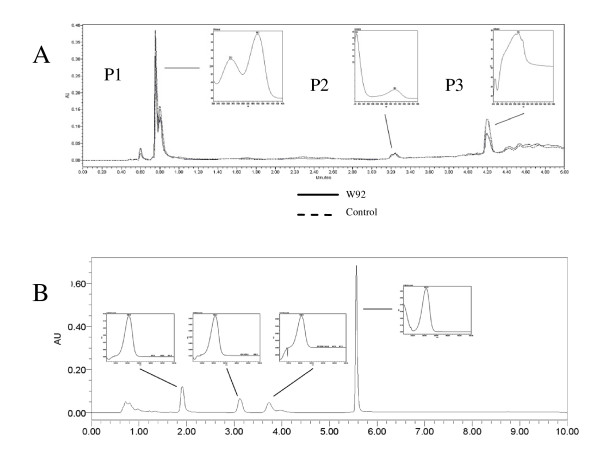
Separation of methanol extracted components from fibres from control and transgenic plants by UPLC. A. Separation of components on C18 column, the chromatogram was registered at 280 nm. B. The separation of the main component ( first peak) by HILIC chromatography. The chromatogram was registered at 308 nm.